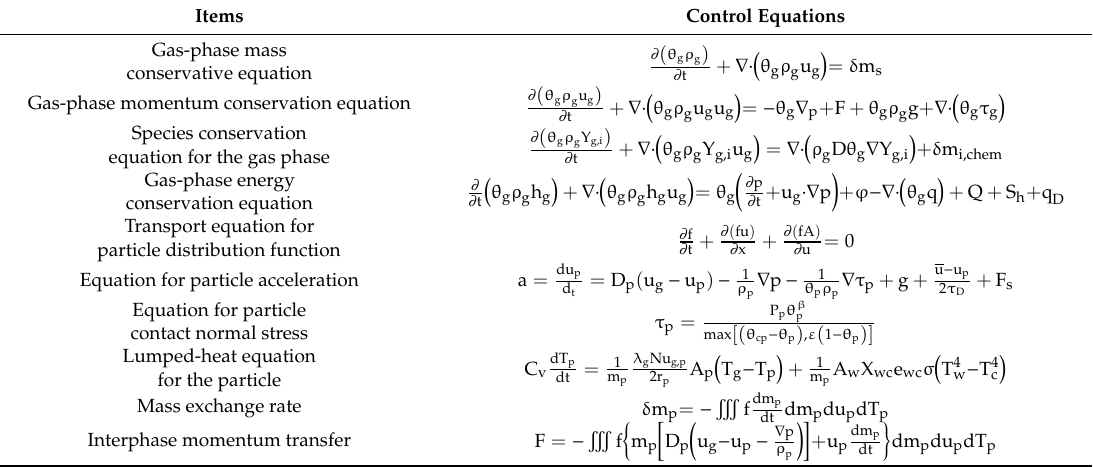
Table 2. Governing equations for gas and solid phases.